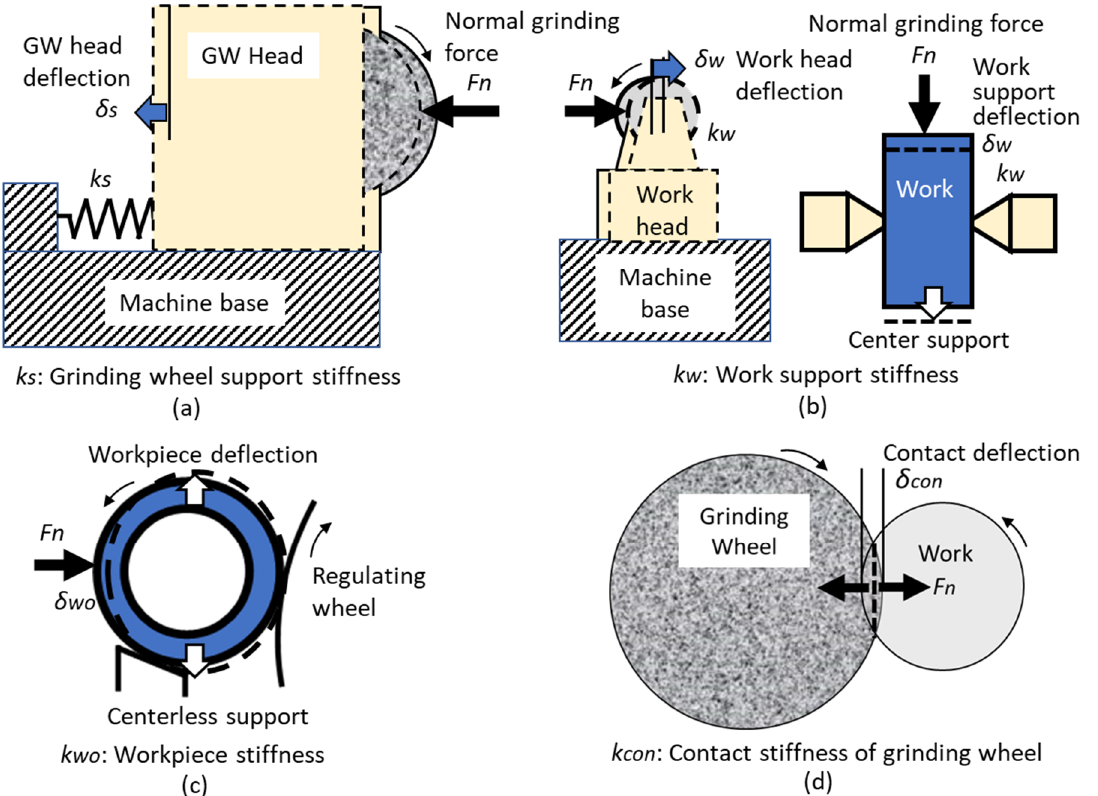
Figure 6. Machine stiffness in a grinding system. ( a ) Grinding wheel support system; ( b ) Work head support system; ( c ) Workpiece stiffness; ( d ) Contact stiffness of grinding wheel.